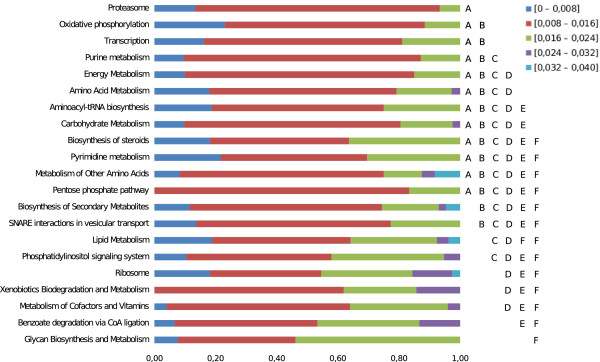
Genetic diversity in metabolic pathways. 657 genes with EC numbers were mapped to the corresponding metabolic pathways in the KEGG database
[72] and sorted based on the nucleotide diversity (π) estimator of the selection acting on the gene. Different letters (on the right) mean statistically significant differences (Kruskal-Wallis test, P < 0.0013; a posteriori test P < 0.05).